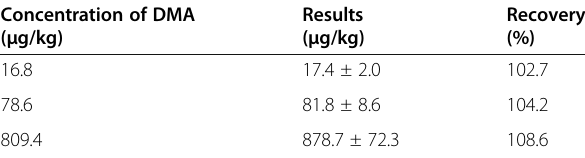
Table 4 Determination of DMA by IC-ICP-MS in solution Concentration of DMA ( μ